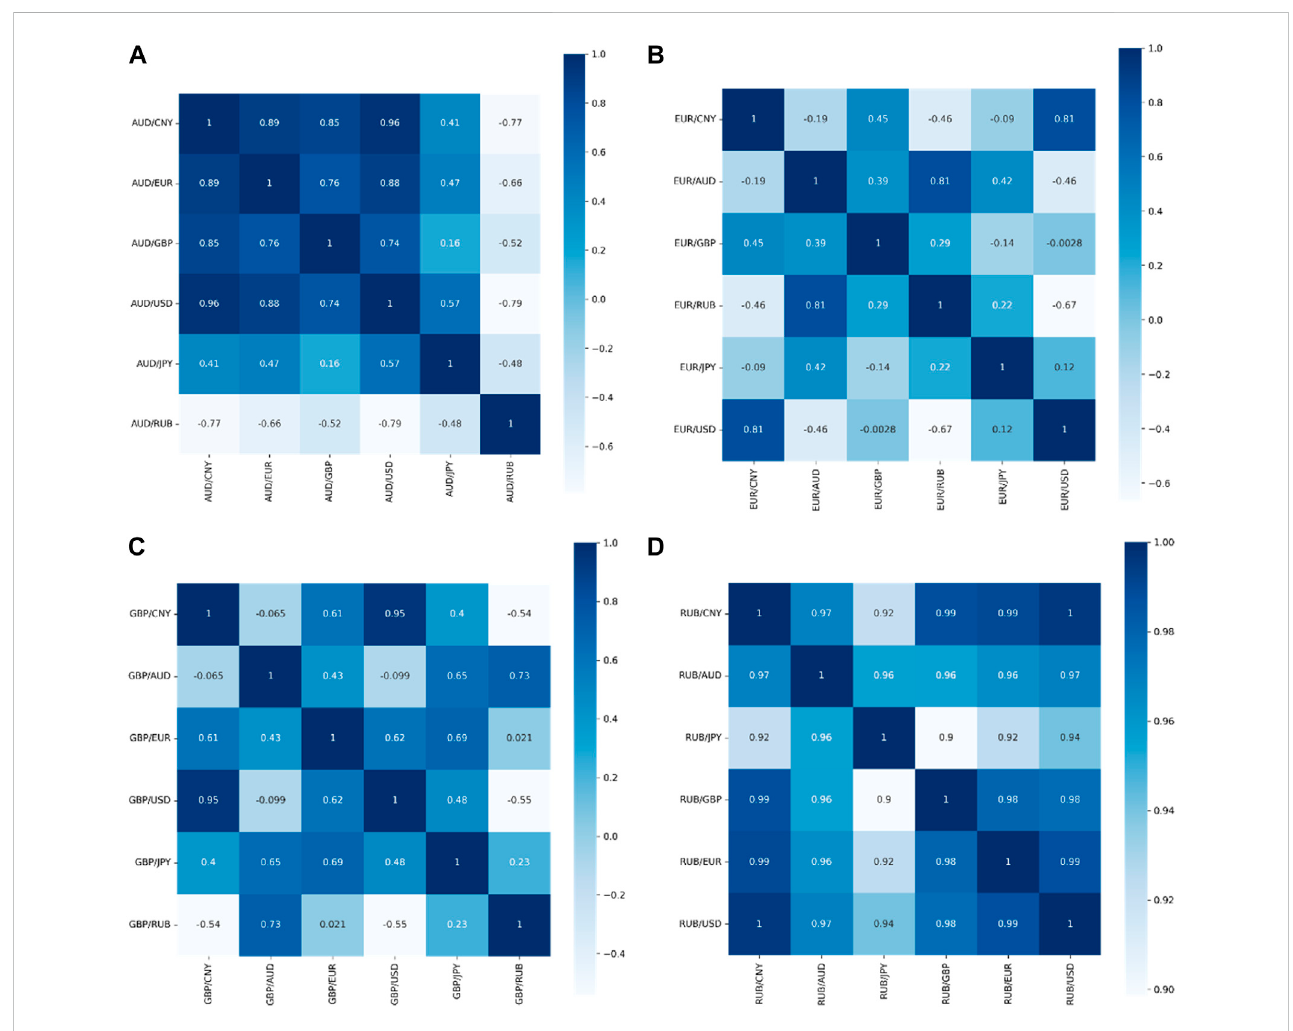
FIGURE 4 Plot of correlation coef fi cients for the foreign exchange